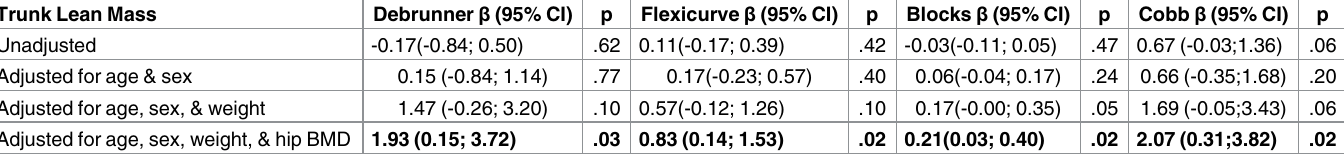
Table 3. Linear regression results of the association of trunk lean massand kyphosis.